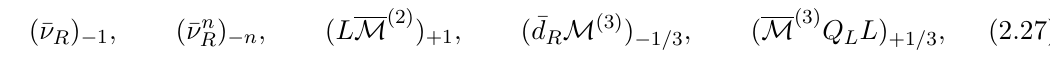
singlet operators with SM